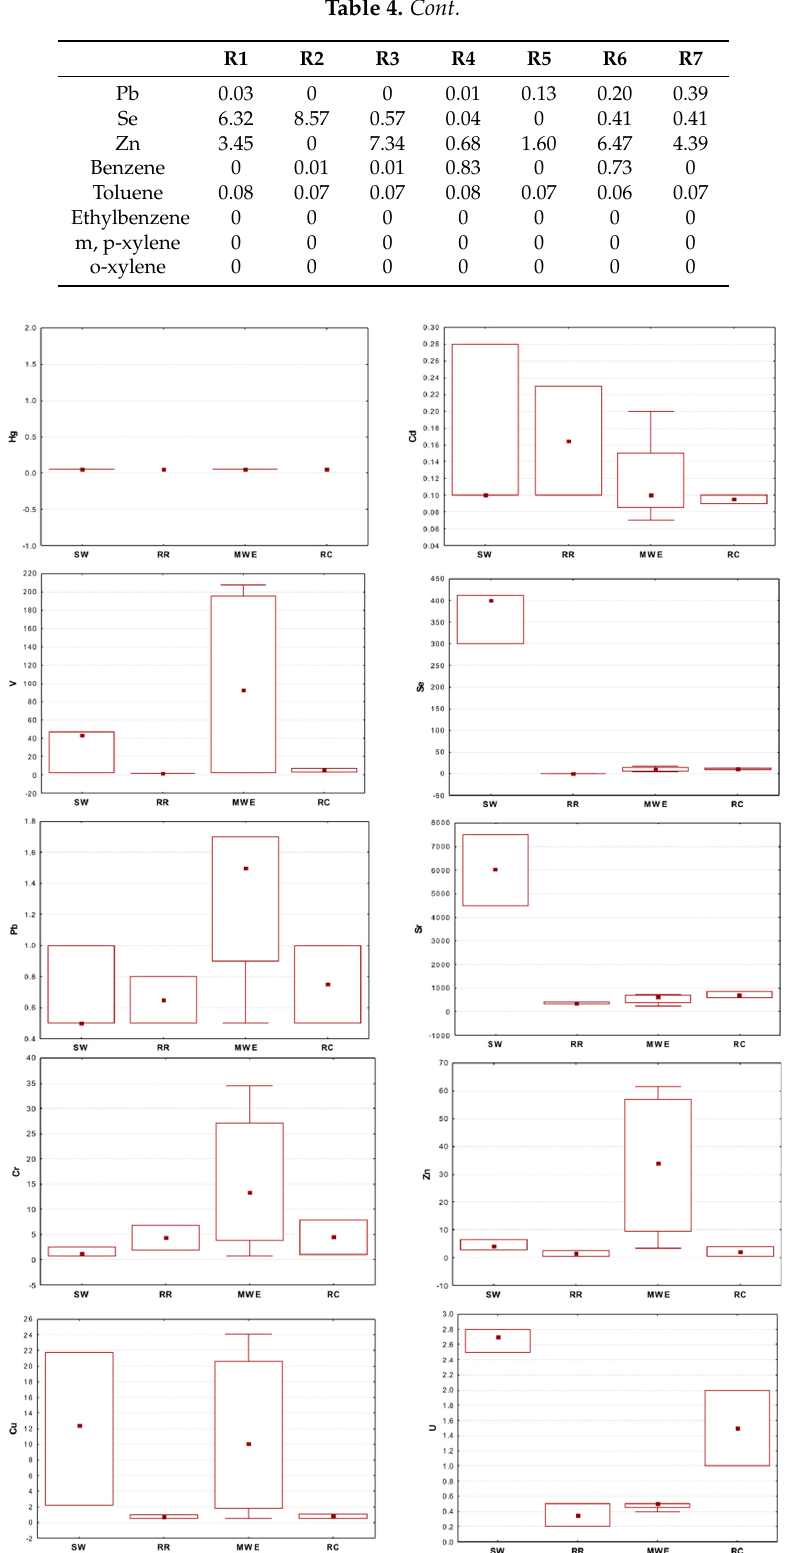
Figure 5. Box-plots of total element concentrations (µg/L) measured in surface water samples (2015-campaign: SW—seawater, RR—Raša River, MWE—municipal wastewater effluent, and RC—water flowing out of a SHOS Raša coal mine (the Krapan site). Whiskers—min-max values, box—Q 1 –Q 3 values, the middle point in a box—median value.